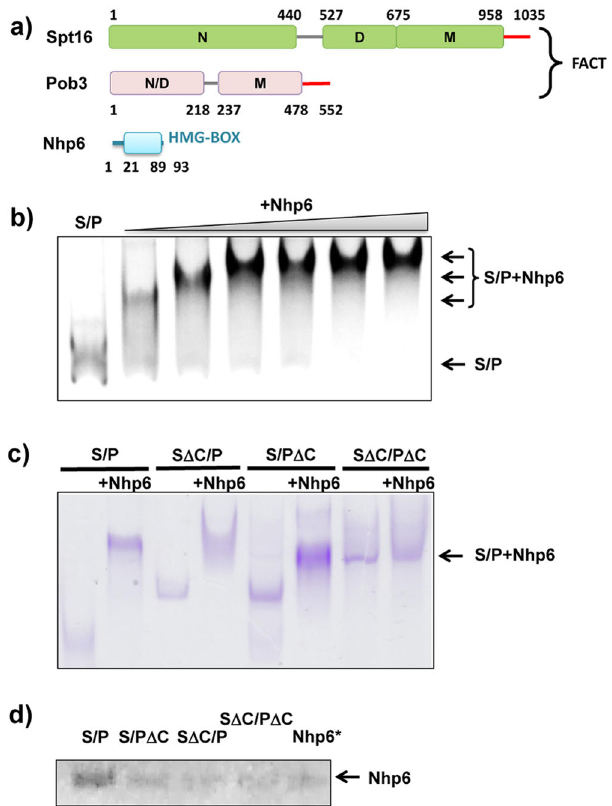
Fig. 1 Nhp6 protein interacts with C-terminal domains of FACT